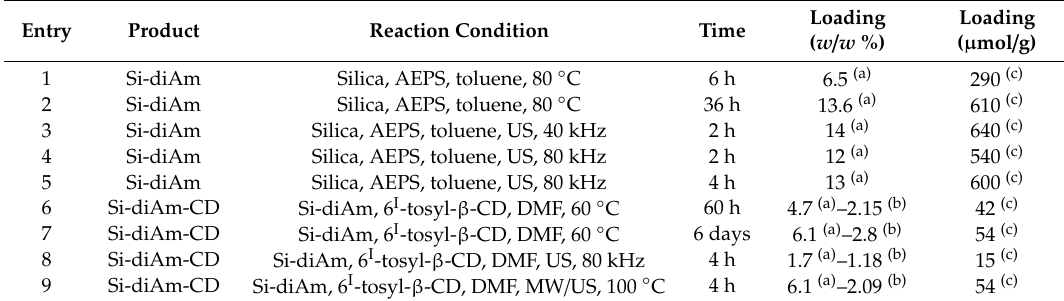
Table 3. Synthesis of